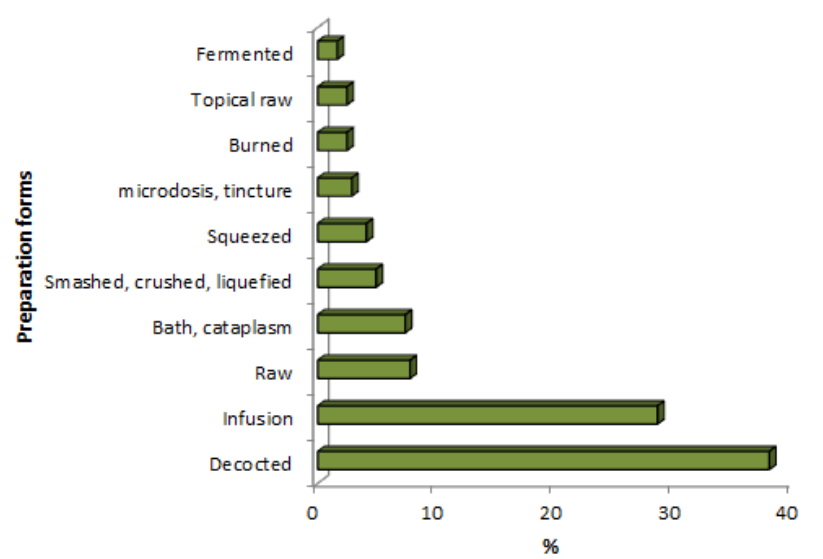
Figure 2. Remedies preparations expressed as percentages (%).